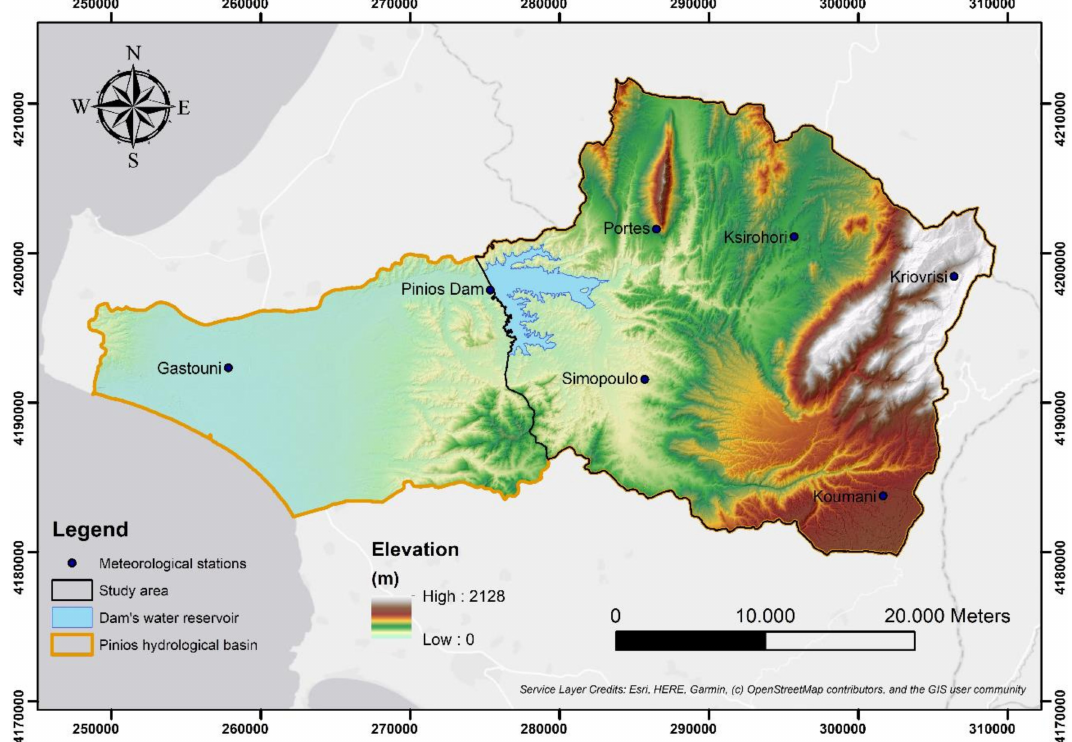
Figure 4. Digital Elevation Map (DEM) of the pilot